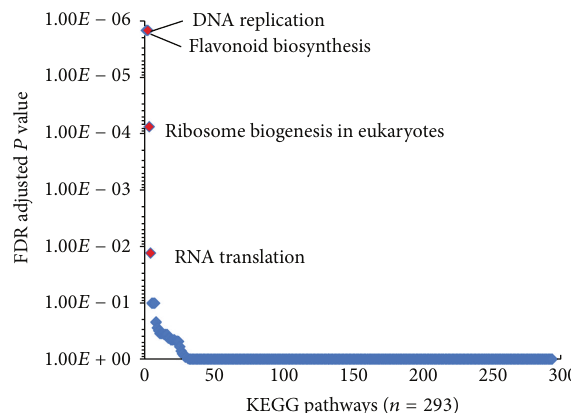
Figure 4: Pathway enrichment based on the profile of combined unique gene